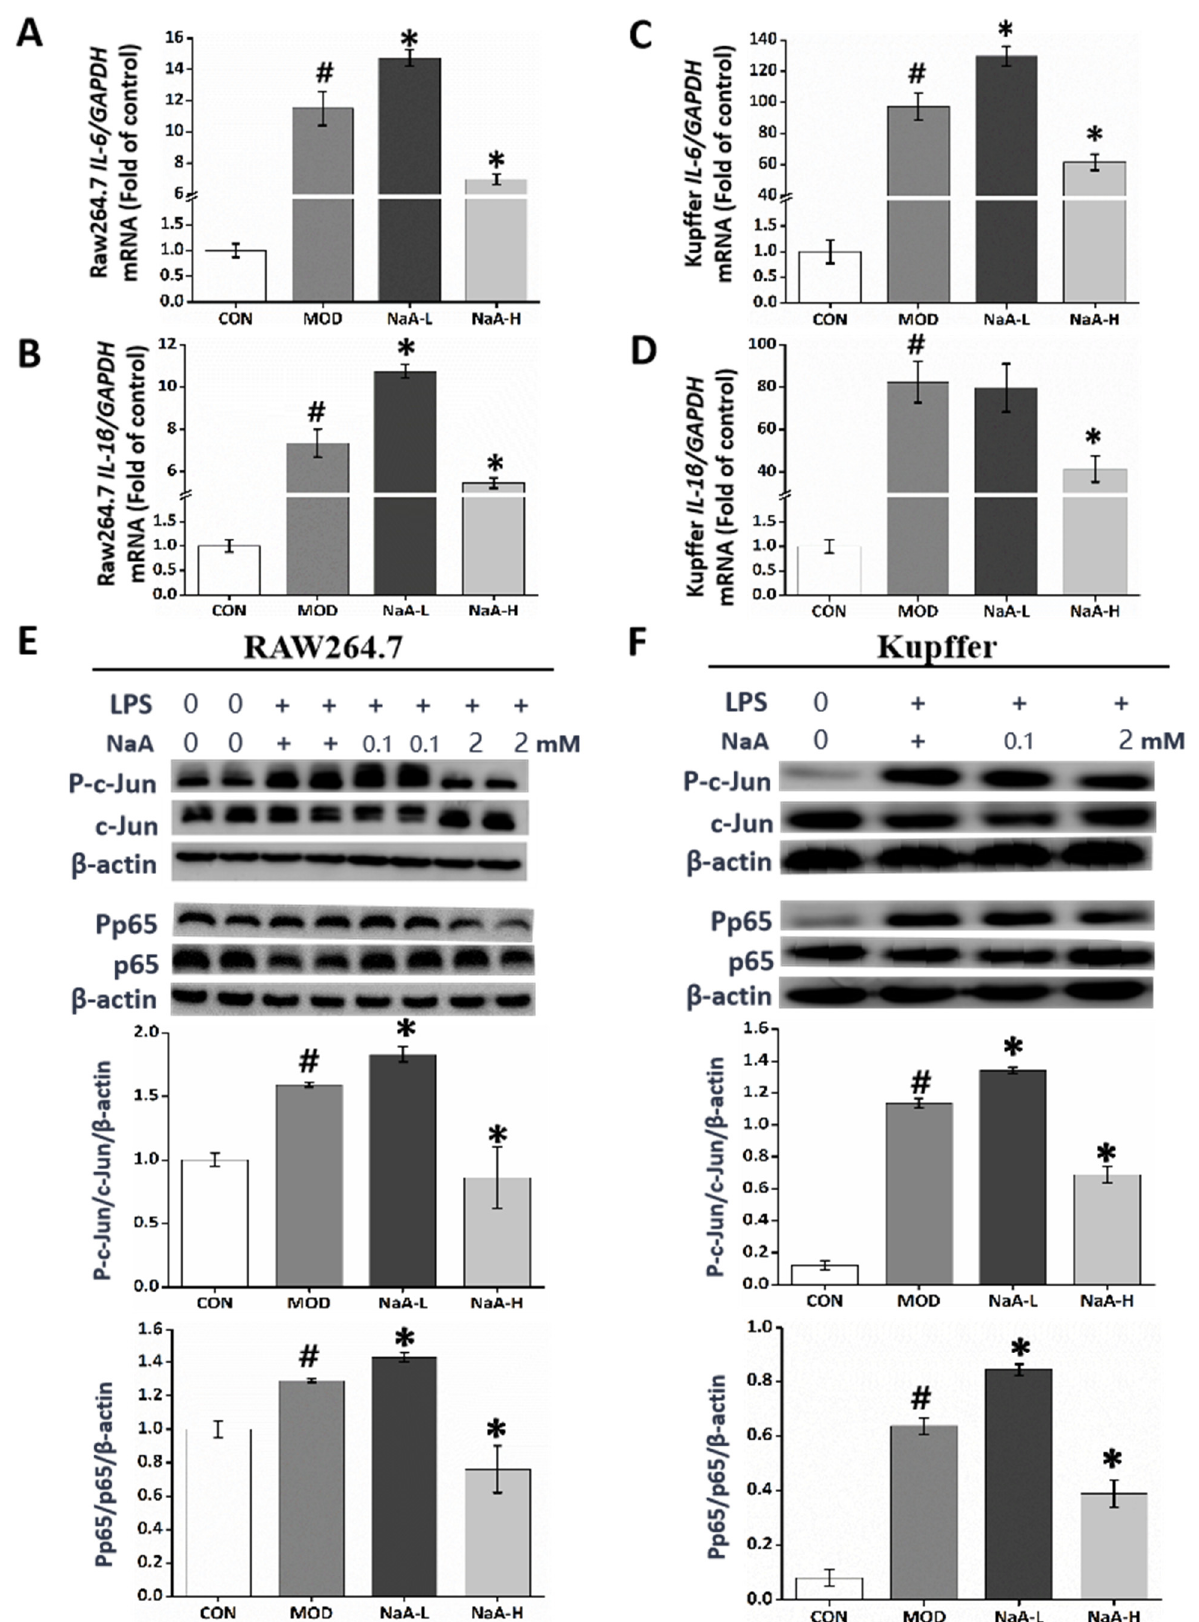
Figure 2. A high or low dose of NaA regulated LPS-induced macrophage activation with opposite effects. Cells were treated with or without 20 ng/mL LPS for 6 h and different doses of NaA for 24 h, as detailed in the Materials and methods section. Then qRT-PCR was used to evaluate the